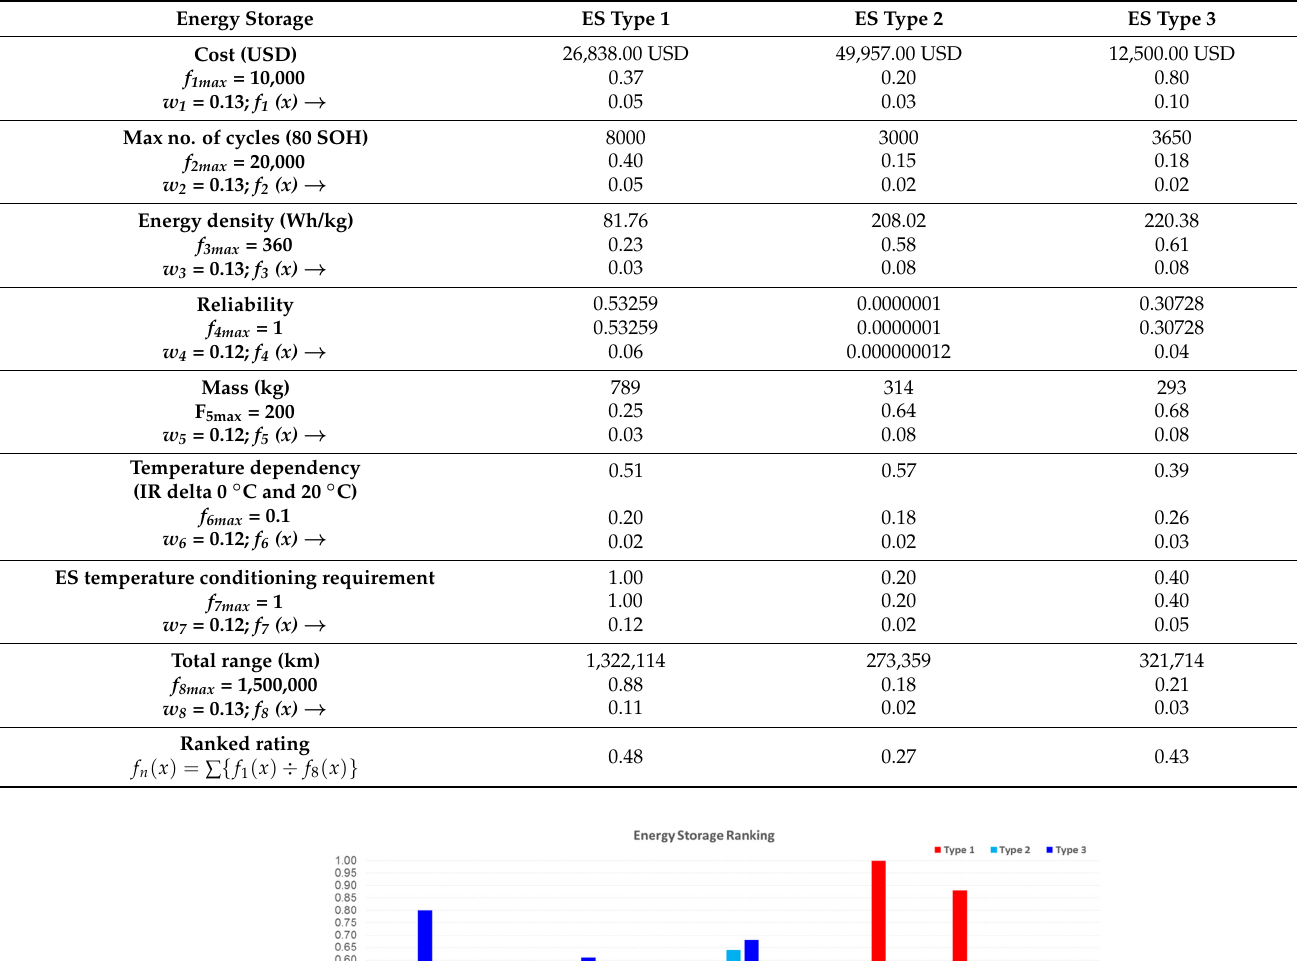
Table 8. Total achievable range for different types of energy storage -WLTC test at 20 °C ambient temperature.